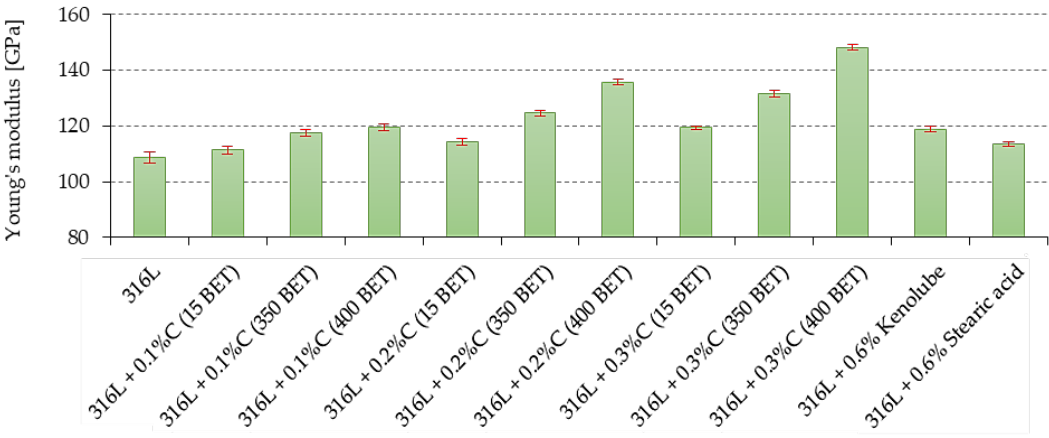
Figure 8. Young’s modulus of sinters depends on the percentage composition of mixtures.